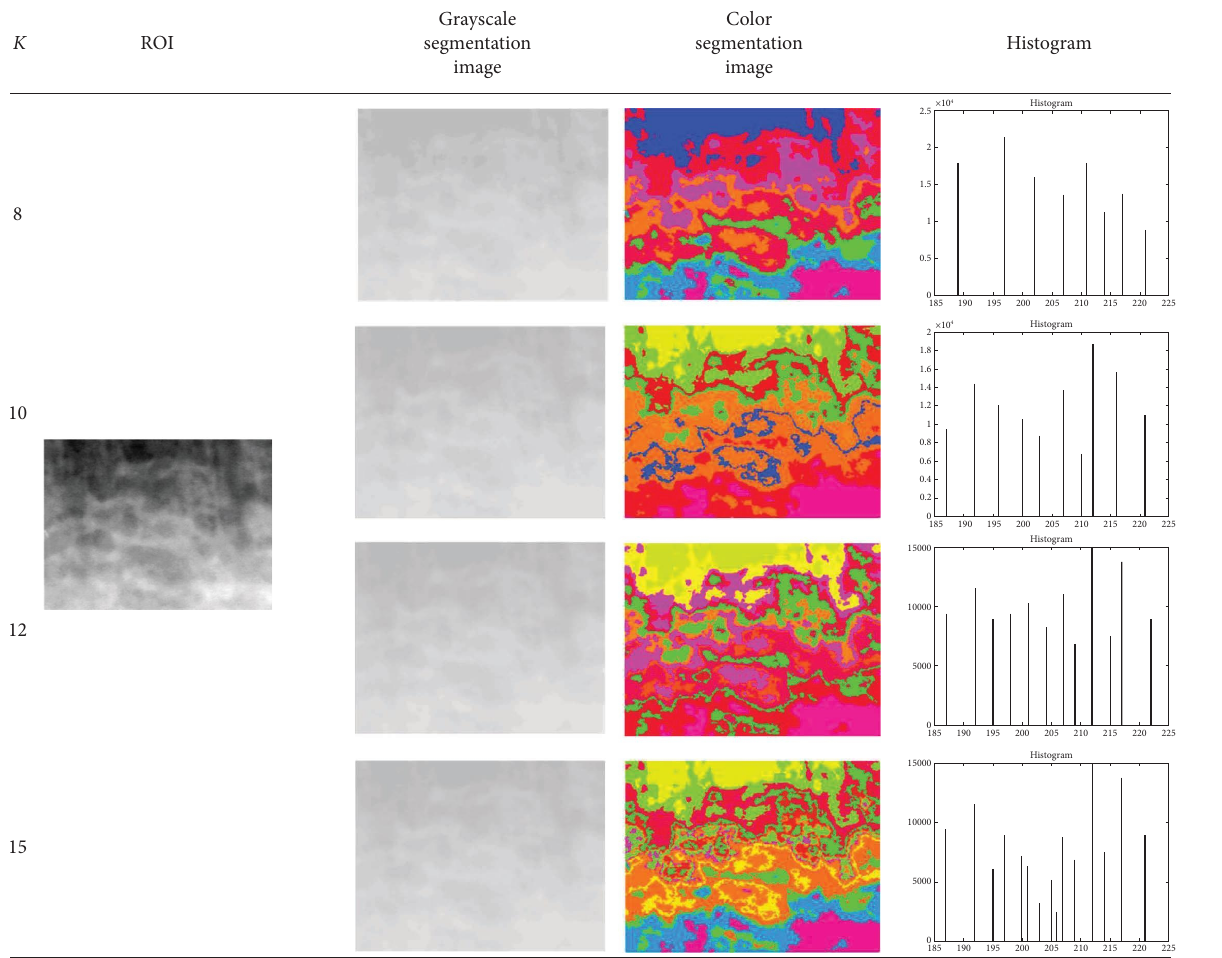
Table 2: Te results of segmentation using Fuzzy